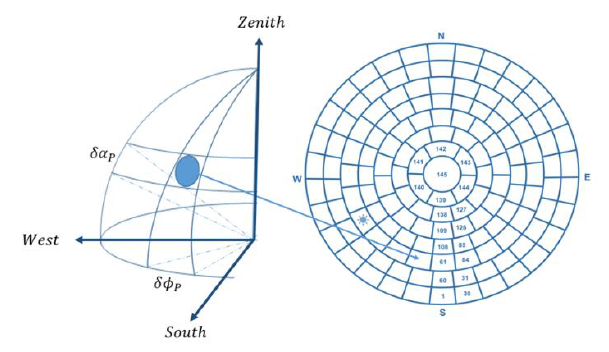
Figure 2. Angles defining the position of a sky element and the pattern of the 145 sky patches.